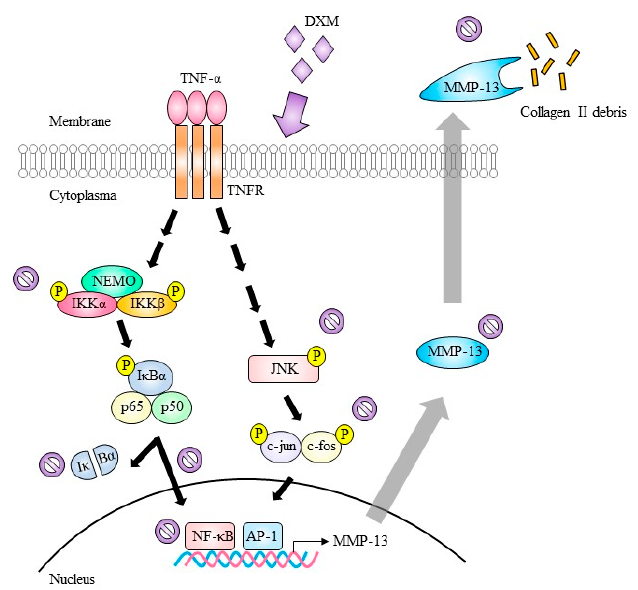
Figure 7. Depicted mechanisms showing how DXM mediates anti-inflammation through blocking TNF- α -induced MMP-13 expression and Col II degradation. Under TNF- α stimulation, the NF- κ B and AP-1 signaling are activated to promote MMP-13 transcription. Enhanced expression of MMP-13 was secreted to cause destruction of extracellular matrix elements, such as collagen II. With DXM treatment, both IKK-I κ B α -NF- κ B and JNK-AP-1 signaling pathways were blocked, and MMP-13 expression was decreased to attenuate TNF- α -induced damage of collagen II. The DXM treatment can thus provide a beneficial effect for treatment of osteoarthritis and possibly other autoimmune arthritis. NEMO: NF- κ B essential modulator. indicate inhibition.